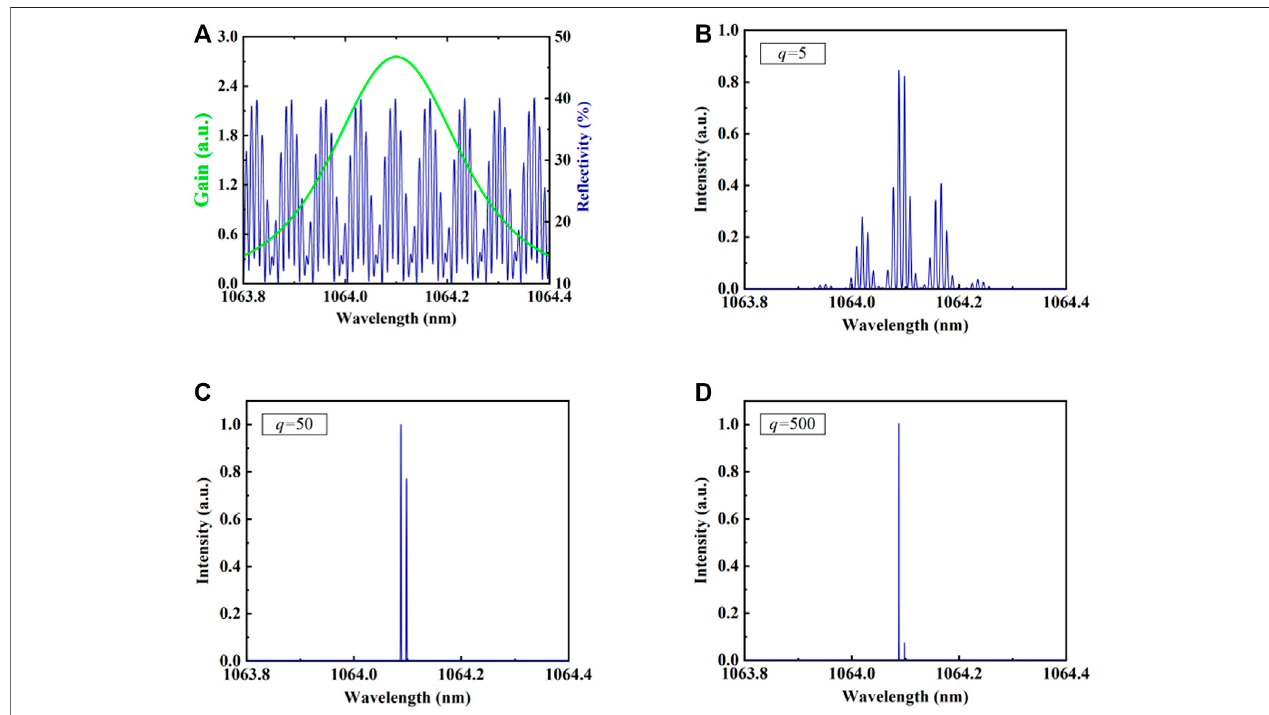
FIGURE2|(A) Gainspectrum(greentrace)andthere fl ectivityoftheresonantmirror(bluetrace)asafunctionoflaserwavelength; (B) modeledlaserspectrumasa function of wavelength for q = 5 transits; (C) modeled laser spectrum as a function of wavelength for q = 50 transits; and (D) modeled laser spectrum as a function of wavelength for q = 500